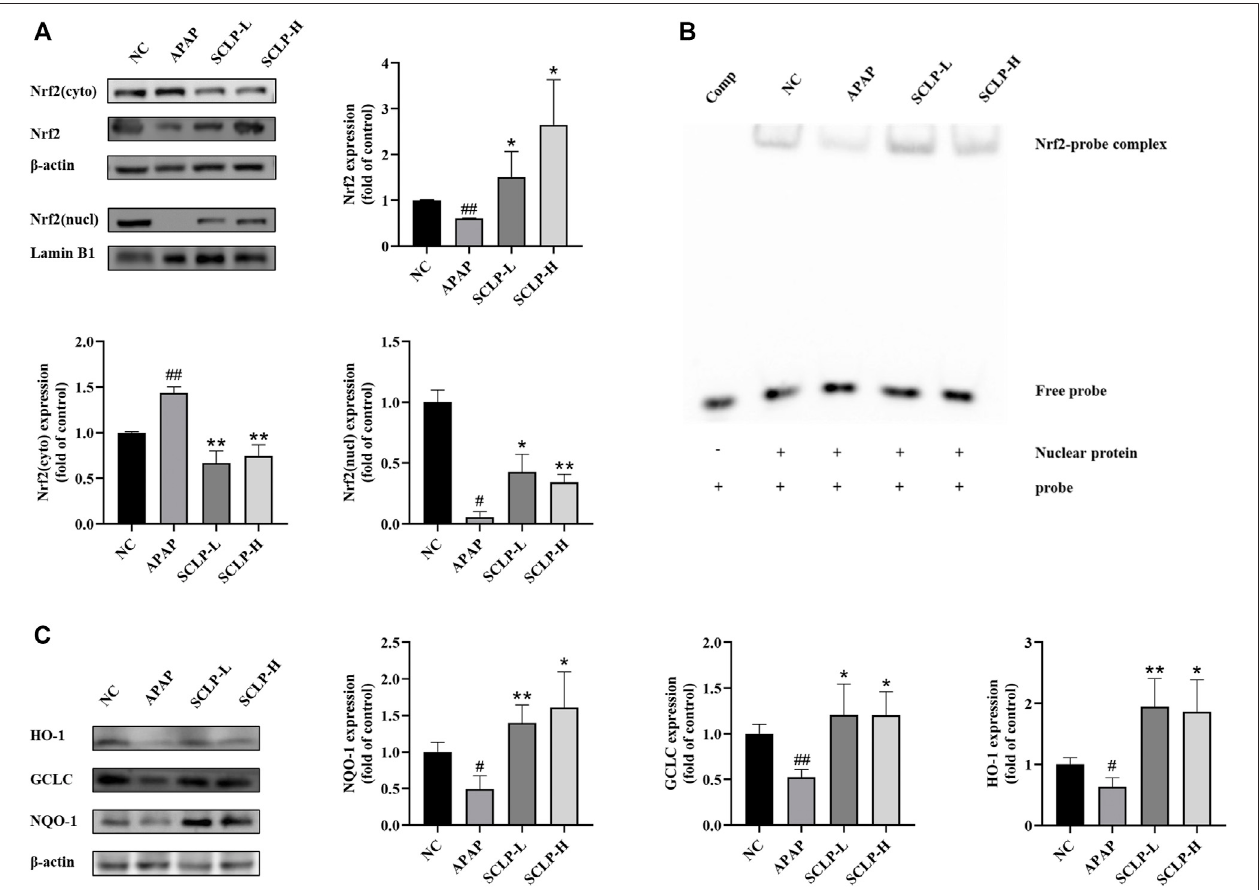
FIGURE 5 | Effect of SCLP on Nrf2-ARE signaling pathway in AILI model mice. Effects of SCLP on Nrf2 protein expression and nuclear translocation (A) ; Effect of SCLP on the binding activity of the complex of Nrf2/ARE (B) ; Effect of SCLP on the expression of antioxidant proteins of Nrf2-ARE signaling pathway in AILI model mice (C) . Data are presented as the mean ± S.D. ( n = 3). # p < 0.05, ## p < 0.01 vs. NC. * p < 0.05, ** p < 0.01 vs.